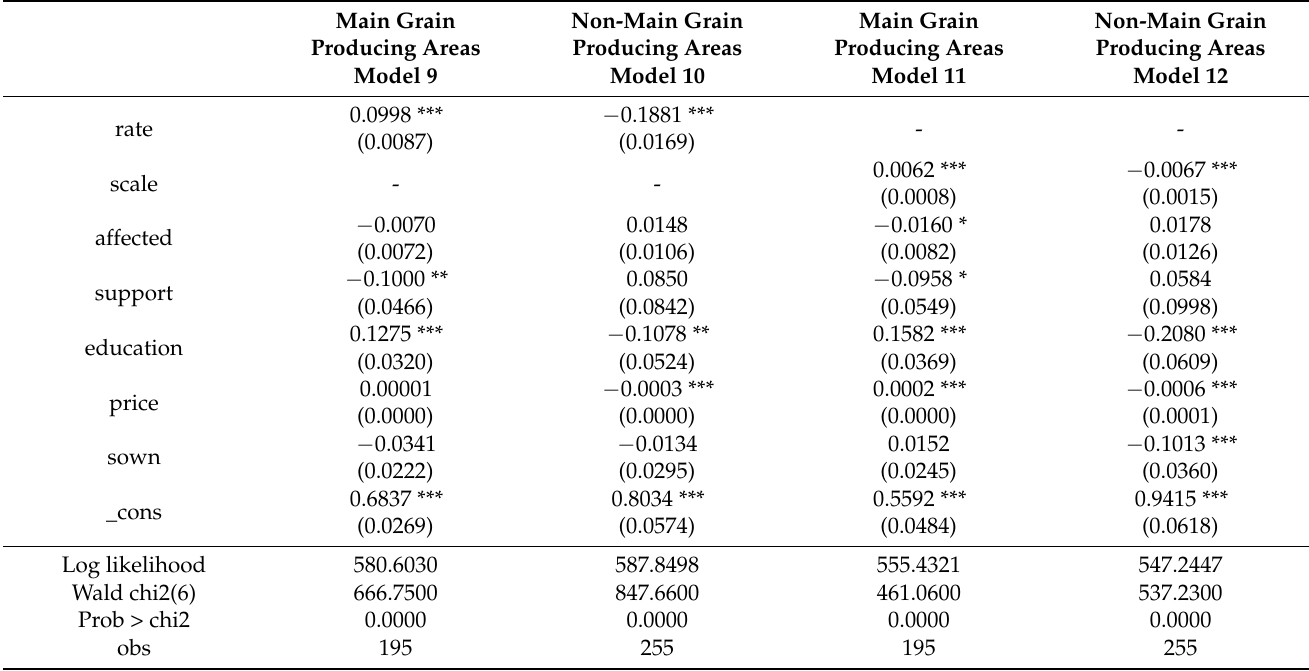
Table 5. Empirical analysis results of the impact of the rural land transfer market on agricultural technical efficiency by region. Main Grain Non-Main Grain Main Grain Non-Main Grain Producing Areas Producing Areas Producing Areas Producing Areas Model 9 Model 10 Model 11 Model